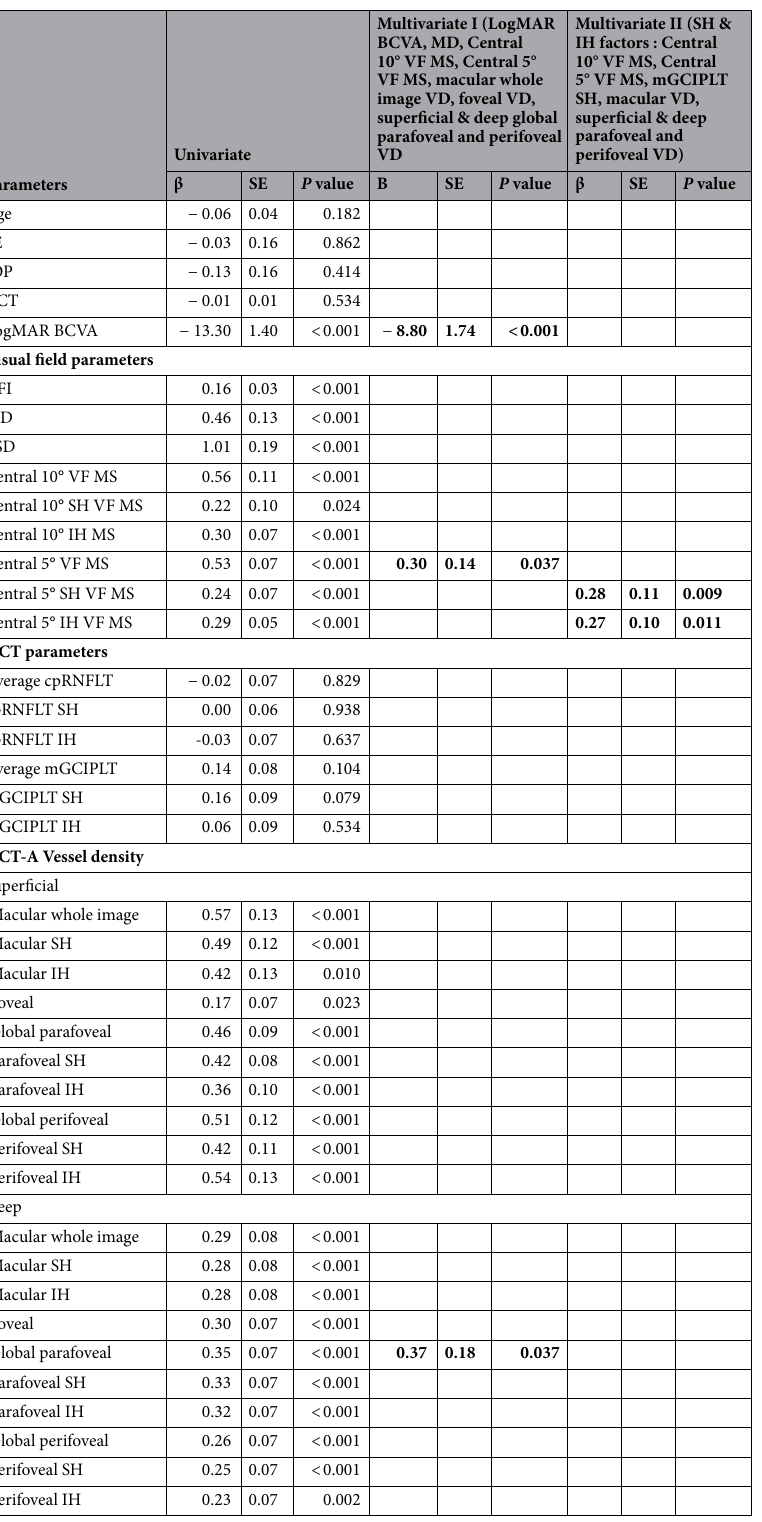
Table 4. Linear regression analyses for the association of clinical characteristics and structure, function, and vessel density parameters with foveal threshold in advanced glaucoma patients. Statistically significant values are in bold. VF MS, visual field mean sensitivity; β, standardized beta coefficient; SE, spherical equivalent; IOP, intraocular pressure; CCT, central corneal thickness; BCVA, best-corrected visual acuity; VFI, visual field index; MD, mean deviation; PSD, pattern standard deviation; SH, superior hemisphere; IH, inferior hemisphere; OCT, optical coherence tomography; OCT-A, optical coherence tomography angiography; cpRNFLT, circumpapillary retinal nerve fiber layer thickness; mGCIPLT, macular ganglion cell-inner plexiform layer